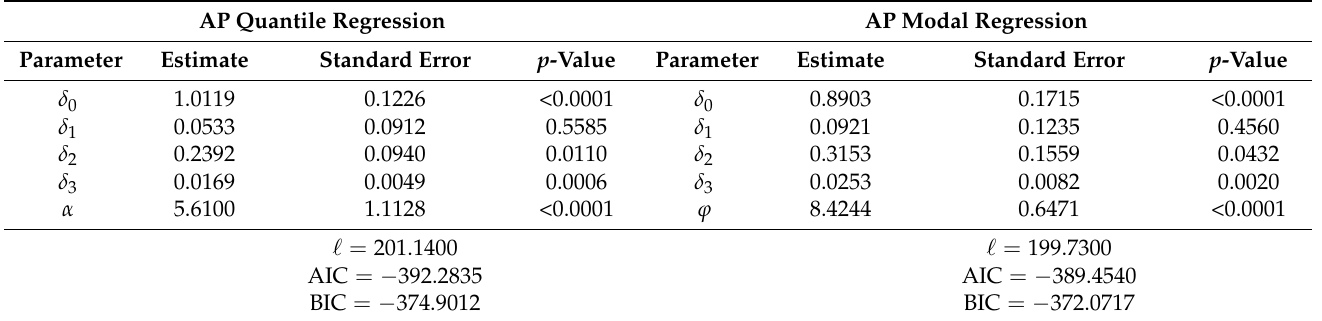
Table 7. Estimates, standard errors, and information criteria for the regression